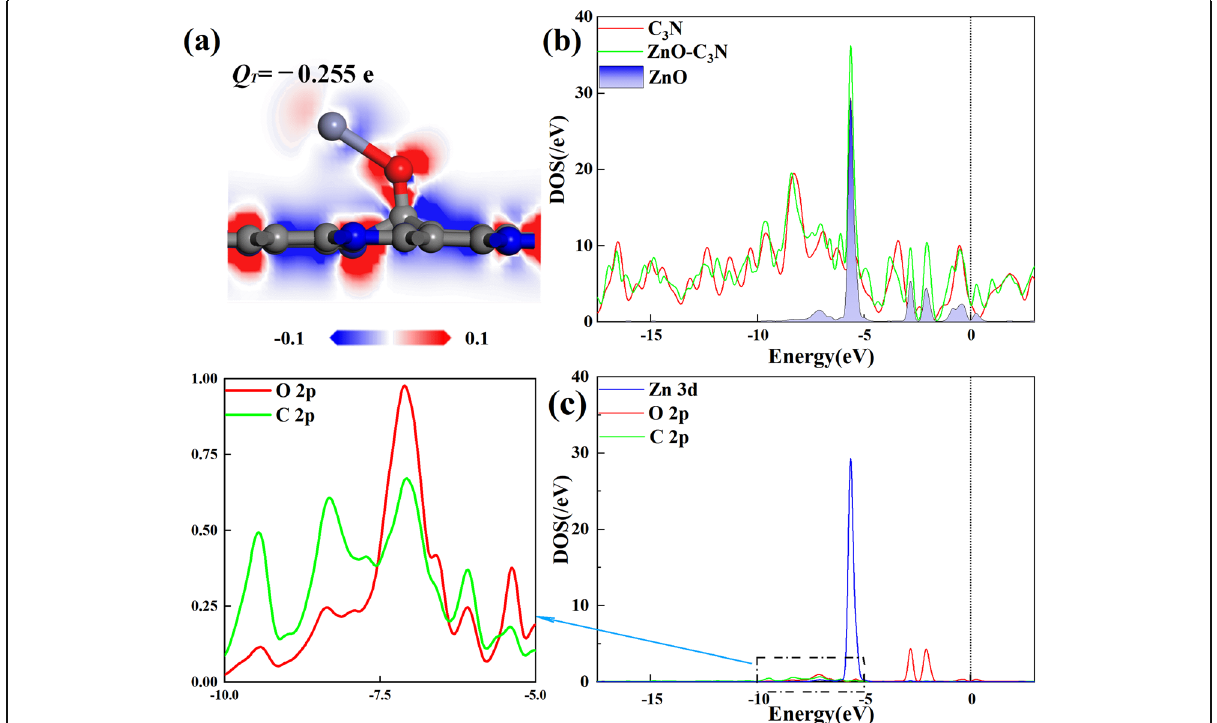
Fig. 3 a DCD and b , c DOS and PDOS of ZnO-C 3 N monolayer